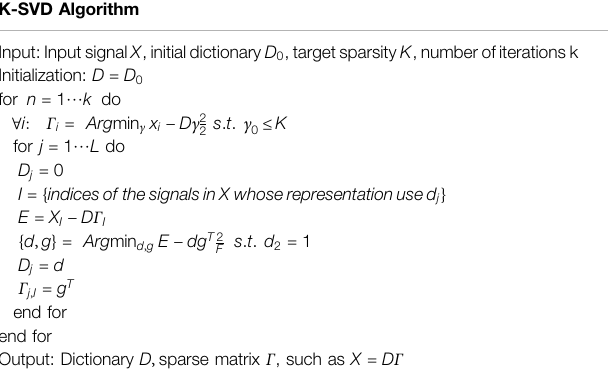
TABLE 2 | Pseudocode of K-SVD algorithm. K-SVD